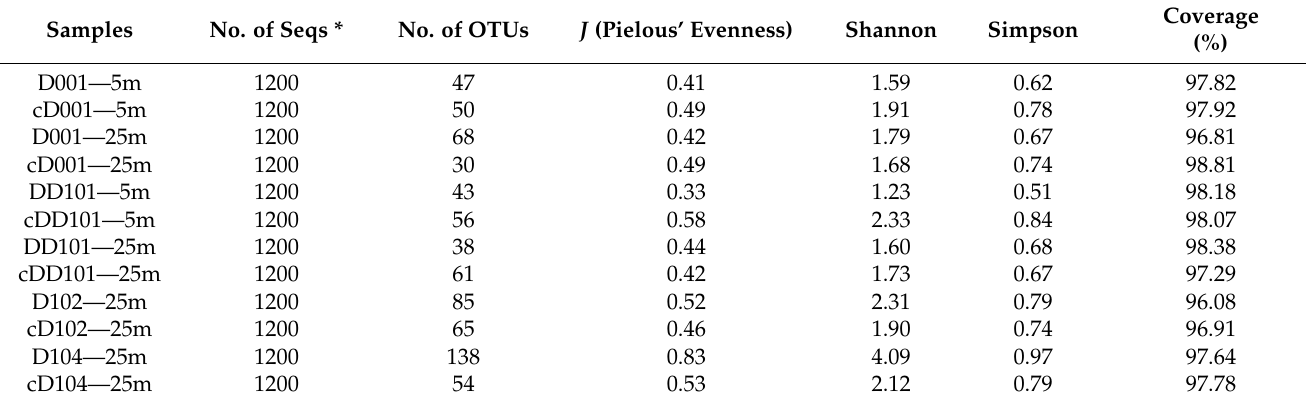
Table 1. Sequencing information and diversity parameters of the AOA amoA gene in the eastern Hainan Island during summer.